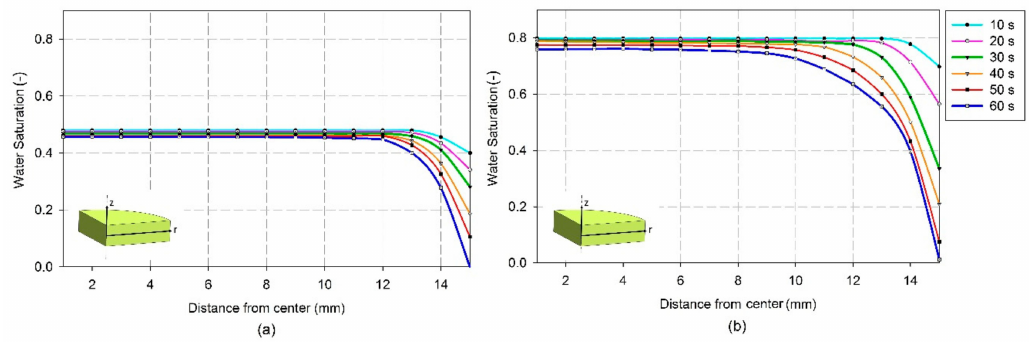
Figure 12. The water saturation profiles of ( a ) unripe bananas, and ( b ) ripe bananas.